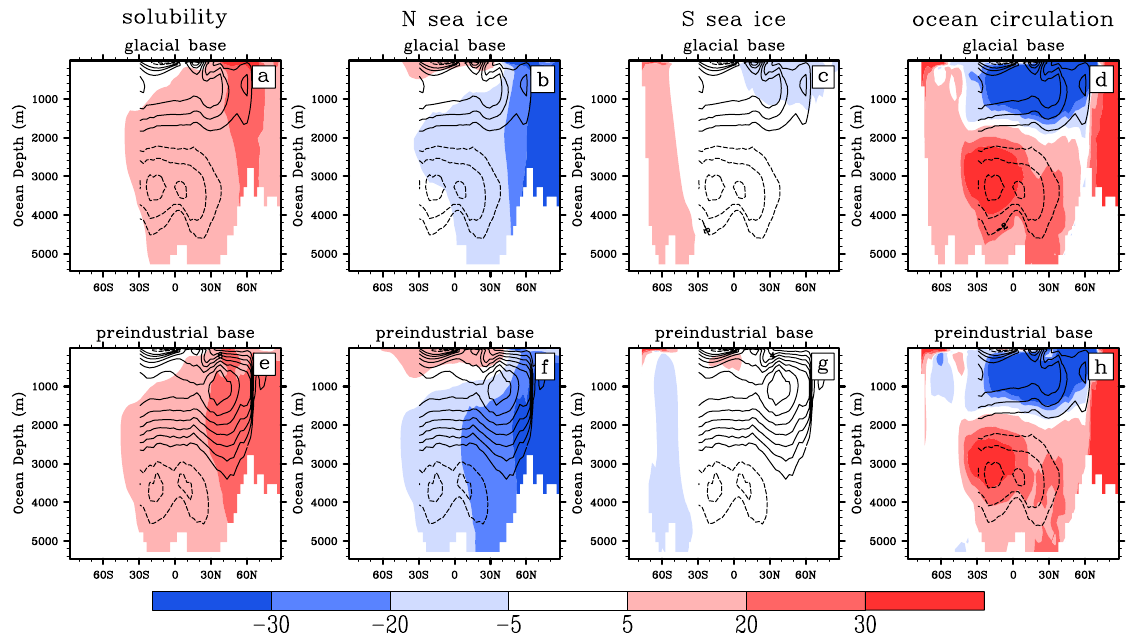
Fig. 10. Zonal-mean DIC anomalies (mmolm − 3 ) due to changes in the solubility, sea ice in the Northern and Southern Hemispheres, and ocean circulation of LGb. Upper (lower) panels correspond to results from the glacial (preindustrial) based climate. Contour lines indicate the overturning stream function of each factorial experiment. Contour intervals are 2Sv.